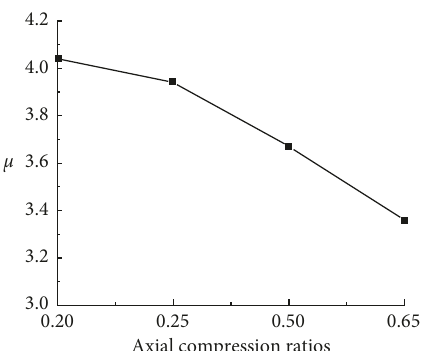
Figure 19: Relationship between various axial compression ratios and ductility coefficients.